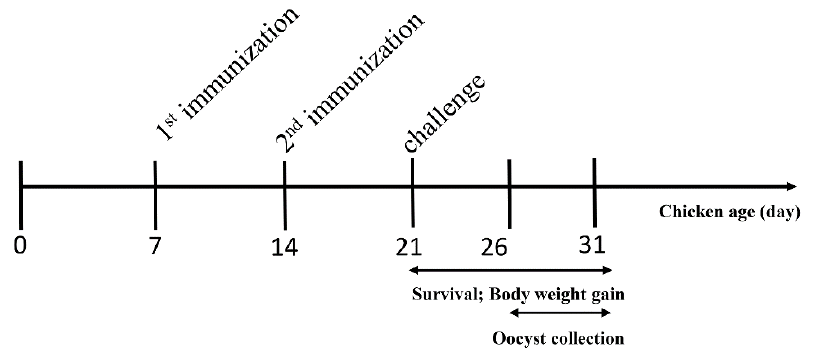
Figure 1. Schematic outline of the experimental design .